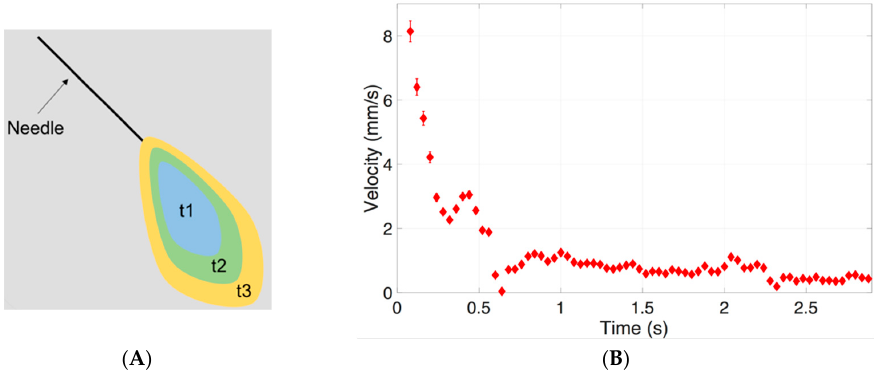
Figure 11. ( A ) Schematic representation of dye area dispersion in vitreous substitute at different time points and ( B ) a typical velocity profile of dye injected into S1000 at a slow injection rate ( Re: 189 ± 91). The velocity of the injected bolus was calculated from changes in bolus length (i.e., square root of the dye area) in time.